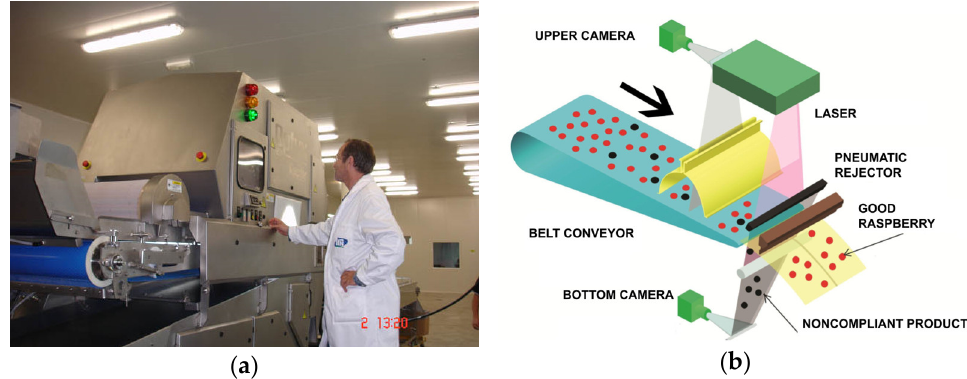
Figure 1. ( a ) Optyx 3000 color sorter in plant; ( b ) schematic representation of the process of color sorting.